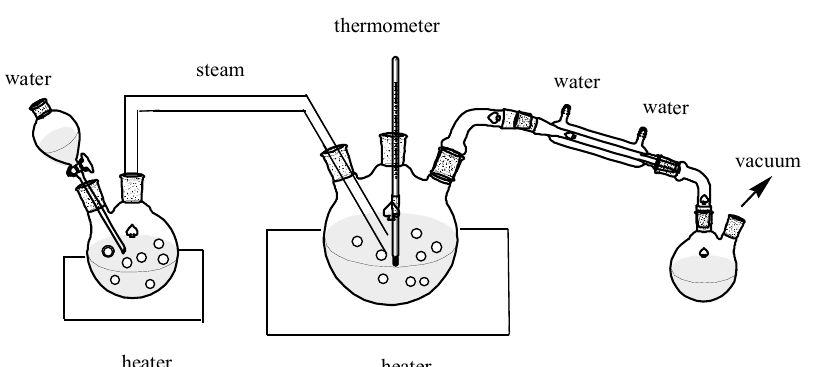
Figure 8. Device diagram of simulated refining experiment in the laboratory. ( A ) degumming and de-acidification; ( B ) water washing; ( C ) decolorizing; and ( D ) deodorization.